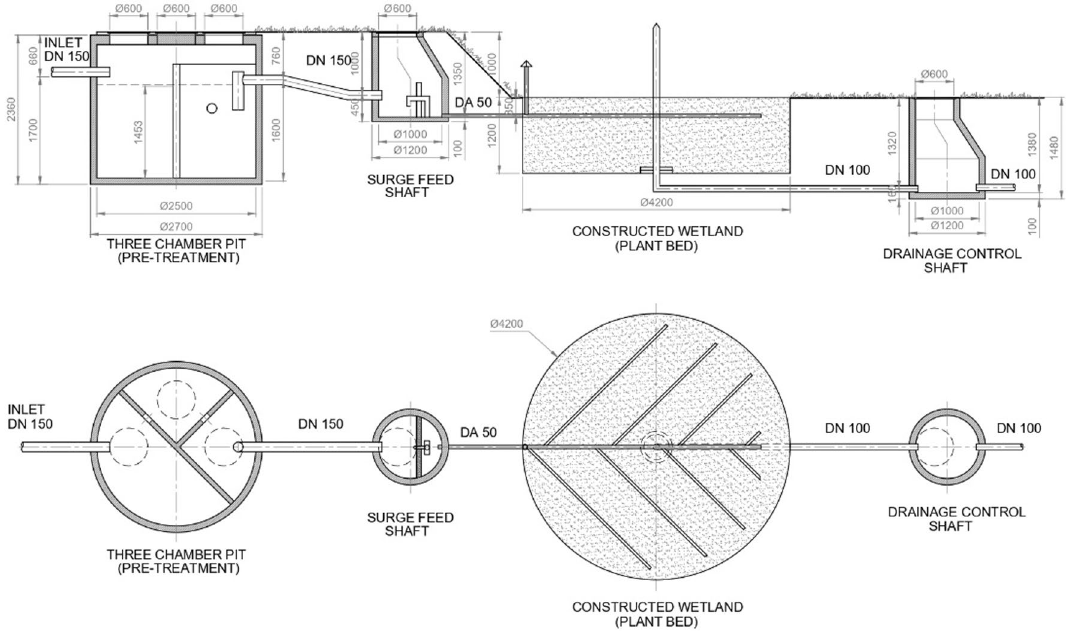
Fig. 1 Layout of Palutec sewerage treatment plant at the Worms adventure garden . Adapted from Mall Umweltsysteme’s graphic for Stadt- verwaltung